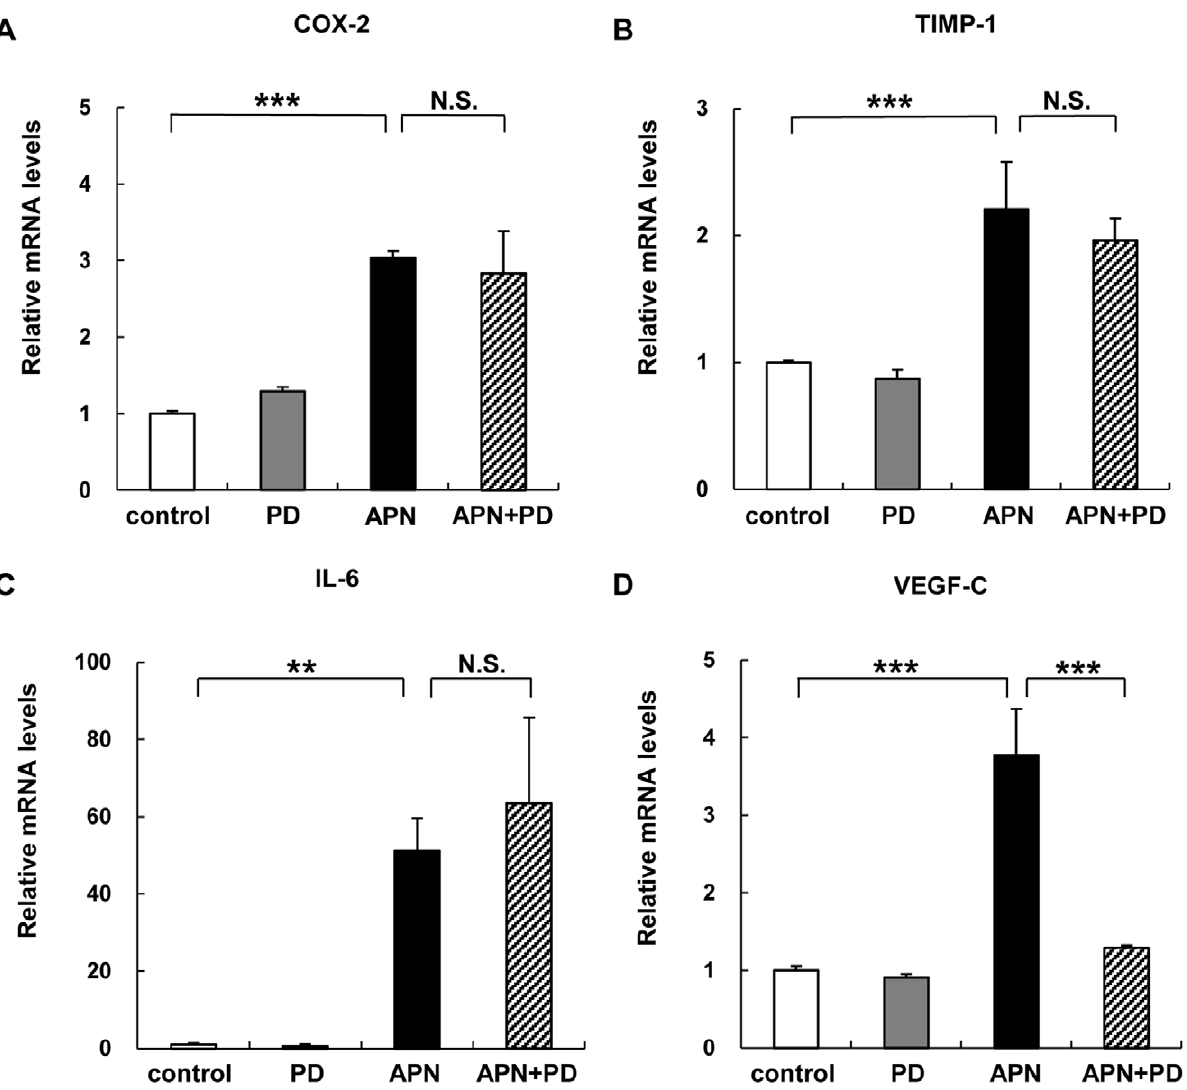
Figure 5. Effects of MEK inhibitor on adiponectin-induced changes in PBDMs. PBDMs were preincubated with 50 m M PD98059 followed by treatment with adiponectin for 6 hours (A-D). The mRNA expression levels of COX-2 (A), TIMP-1 (B), IL-6 (C), or VEGF-C (D) were quantified by real-time PCR. Values are normalized to the level of GAPDH mRNA and expressed as mean 6 SEM (n=3). ***P , 0.001. N.S not significant.